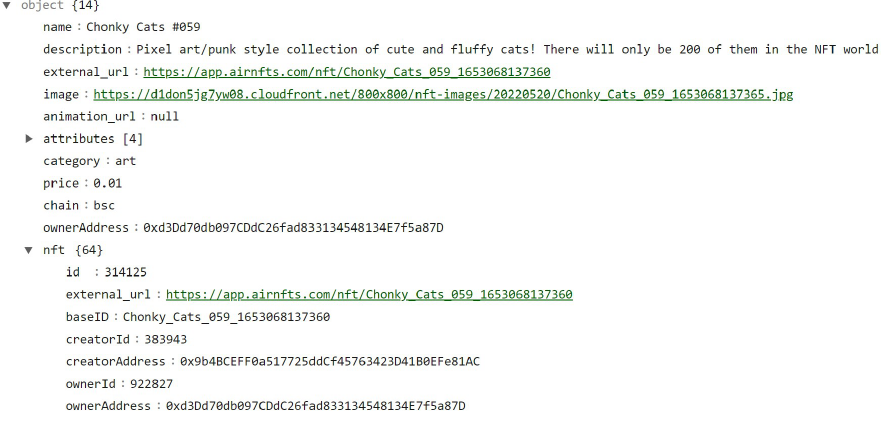
Figure 12. NFT information recovered.